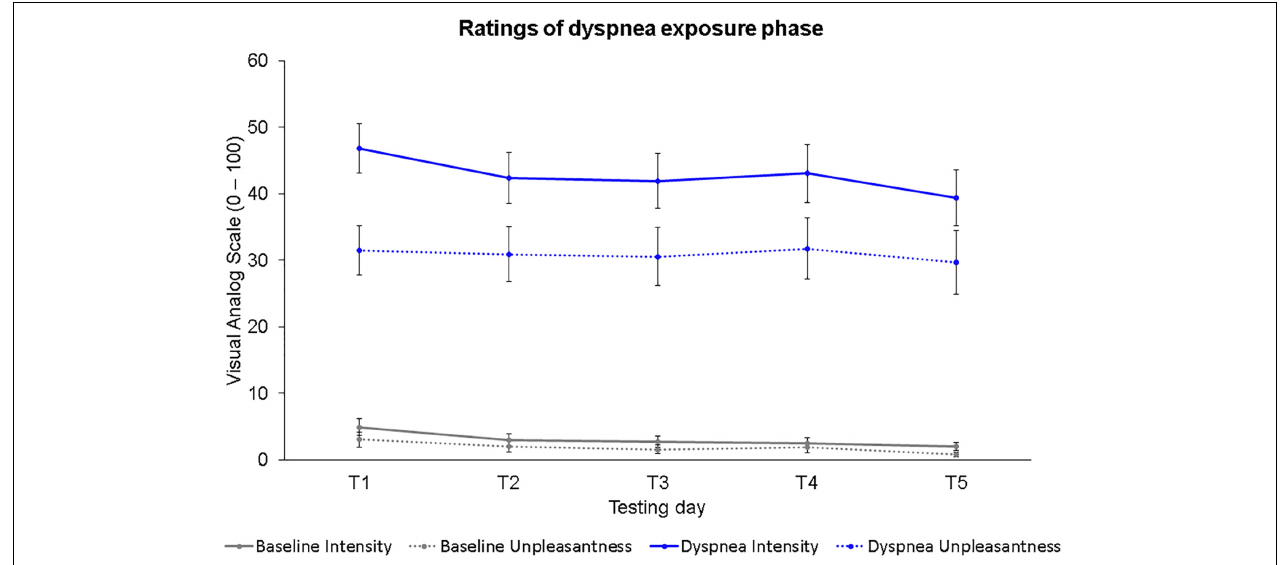
FIGURE 2 | Dyspnea intensity and dyspnea unpleasantness ratings for all five testing days during the dyspnea exposure phases. Dots represent mean values. Error bars represent standard errors.